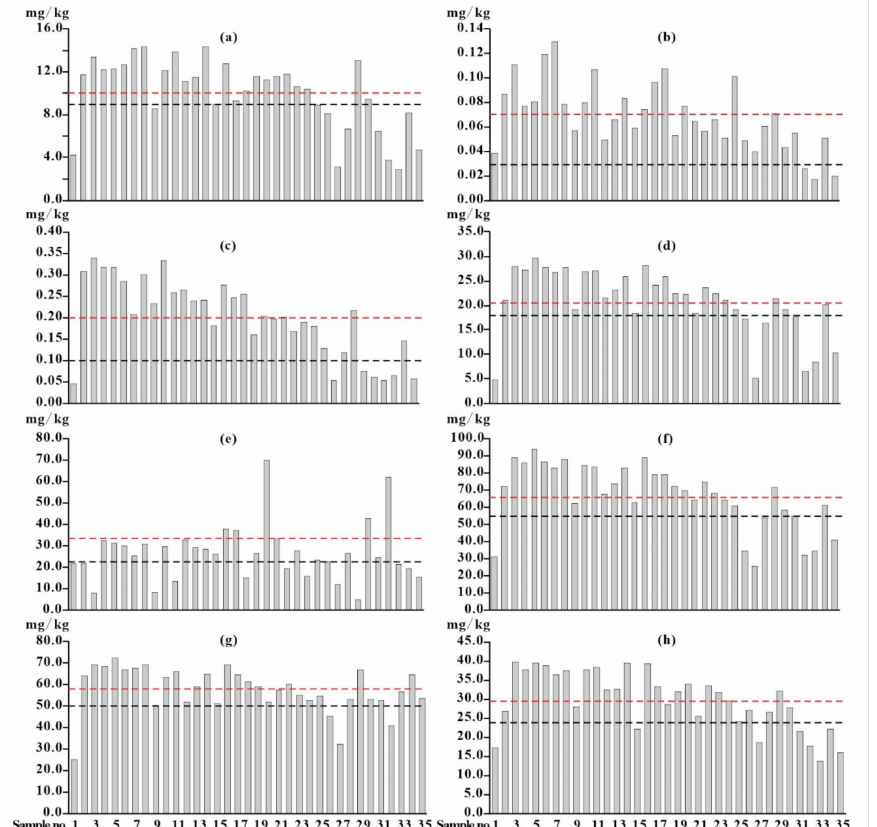
Figure 2. Heavy metals concentrations in the surface sediment from the Chagan Lake. ( a ) As, ( b ) Hg, ( c ) Cd, ( d ) Cu, ( e ) Pb, ( f ) Zn, ( g ) Cr and ( h ) Ni. (Black dash line-background value; Red dash line-mean